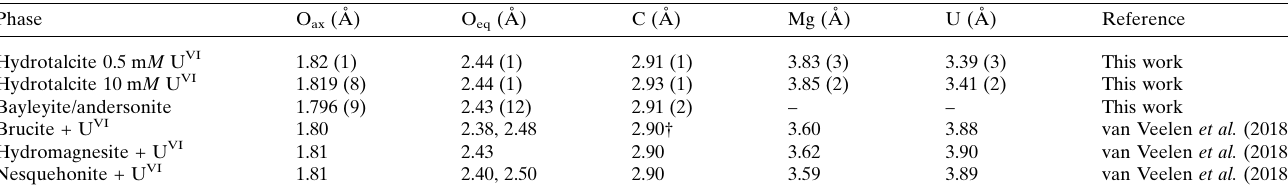
Table 6 Summary of the U– X distances obtained by EXAFS model fitting of 0.5 m M and 10 m M U VI -contacted hydrotalcite, bayleyite/andersonite and U VI - contacted magnesium and/or carbonate mineral phases. Note that errors were not quoted by van Veelen et al.